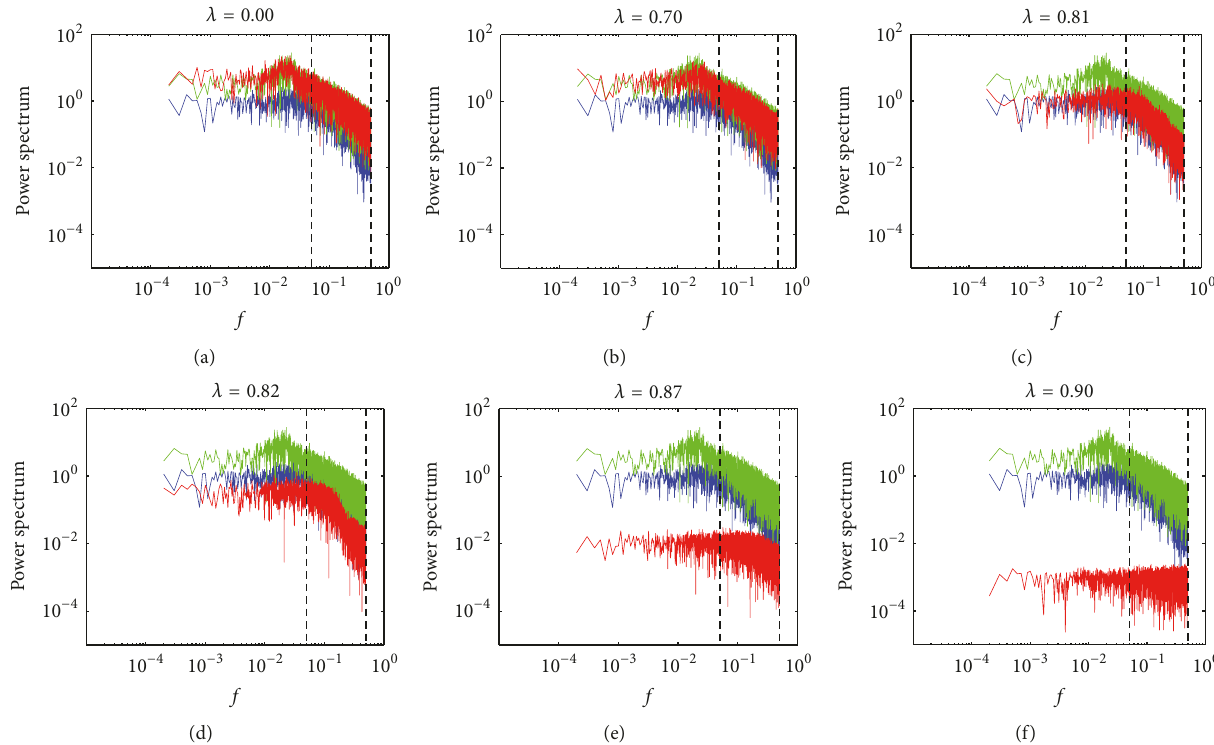
Figure 9: The power spectrum of a number of active agents during a simulation with 𝐿 = 0.82 , using the Fourier transform. In blue we have the result obtained for the model of Epstein and in green the one corresponding to the simulation with heterogeneous saving. In red the cases for the homogeneous saving model are plotted with 𝜆 = [0.00, 0.70, 0.81, 0.82, 0.87, 0.90] , respectively. The dashed lines show the region of the frequency range used to obtain the slope of the decay of the energy cascade in the inertial